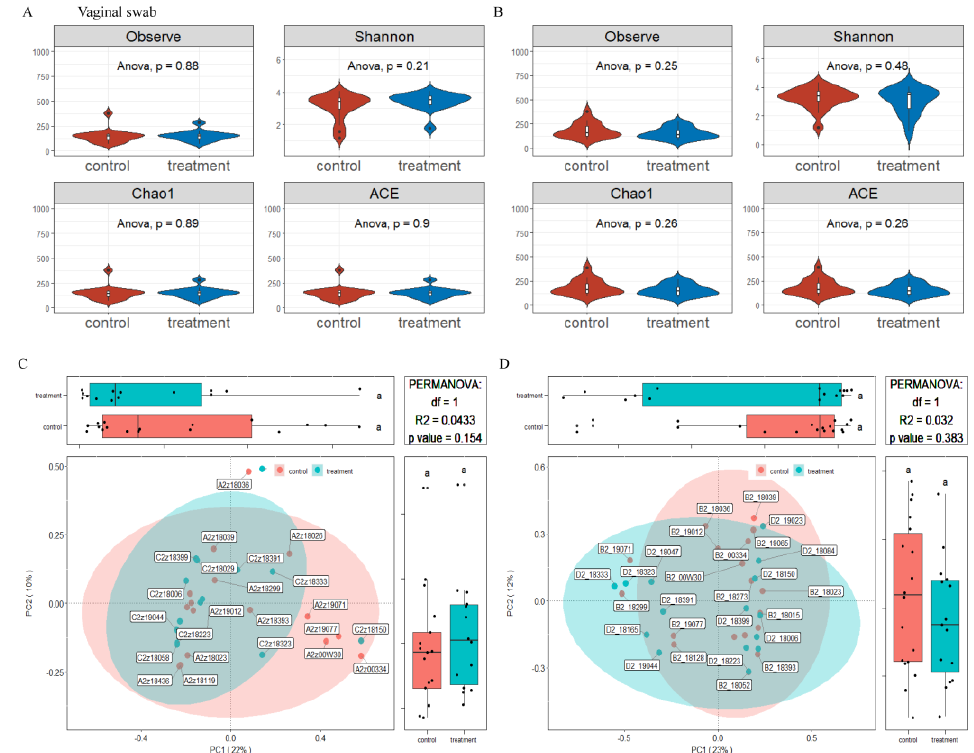
Figure 6. Effects of MSFAs during gestation on the vagina microbiota diversity of sows. Comparison of the number of observed species and Shannon, Chao1 and ACE indexes between the control and treatment groups at day 14 ( A ) and day 28 ( B ) of gestation. Beta diversity of the fecal microbiota in sows between the control and treatment groups at day 14 ( C ) and day 28 ( D ) of gestation based on weighted UniFrac distance. Data are expressed as the mean ± SEM (n = 11). Day 14 of gestation n: control = 12, treatment = 13, Day 8 of gestation n: control = 18, treatment = 15.